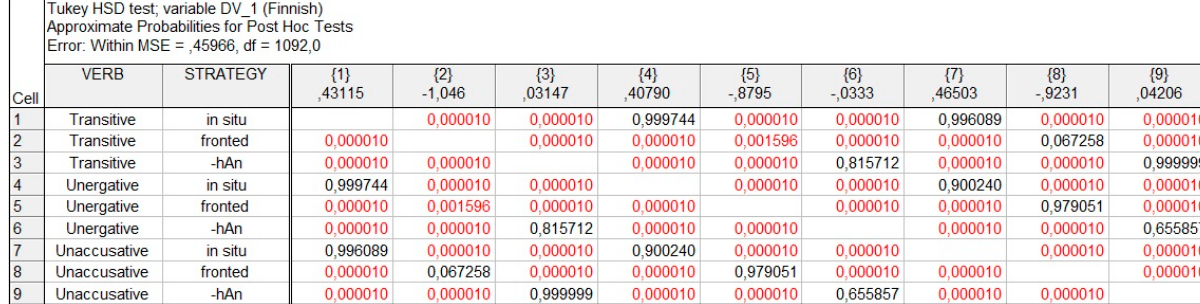
Figure 6. Verb*Strategy post hoc results (Finnish).